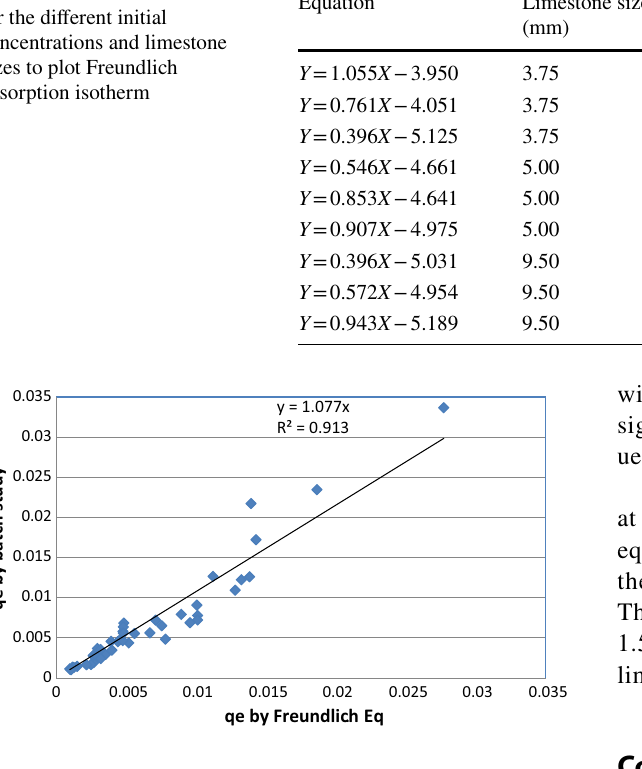
Table 8 Calculated values for the different initial concentrations and limestone sizes to plot Freundlich adsorption isotherm